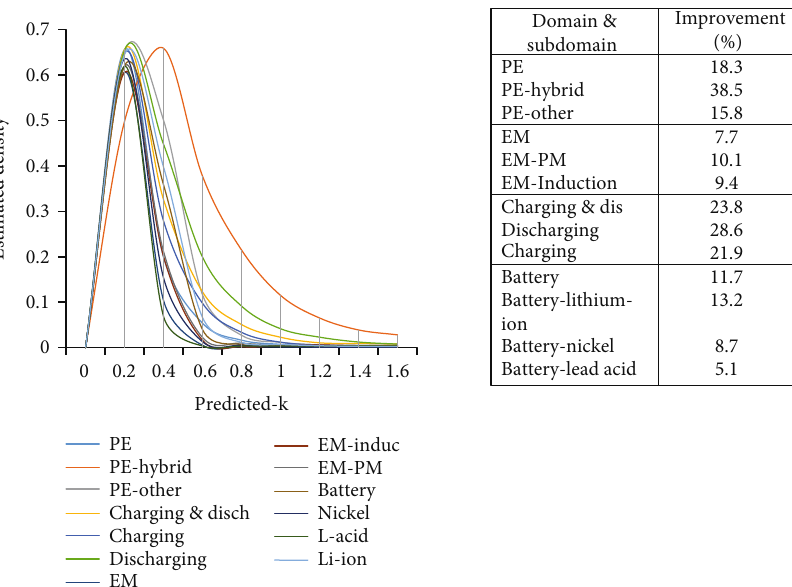
Figure 1: The estimated technological improvement rates of domains and subdomains [43].